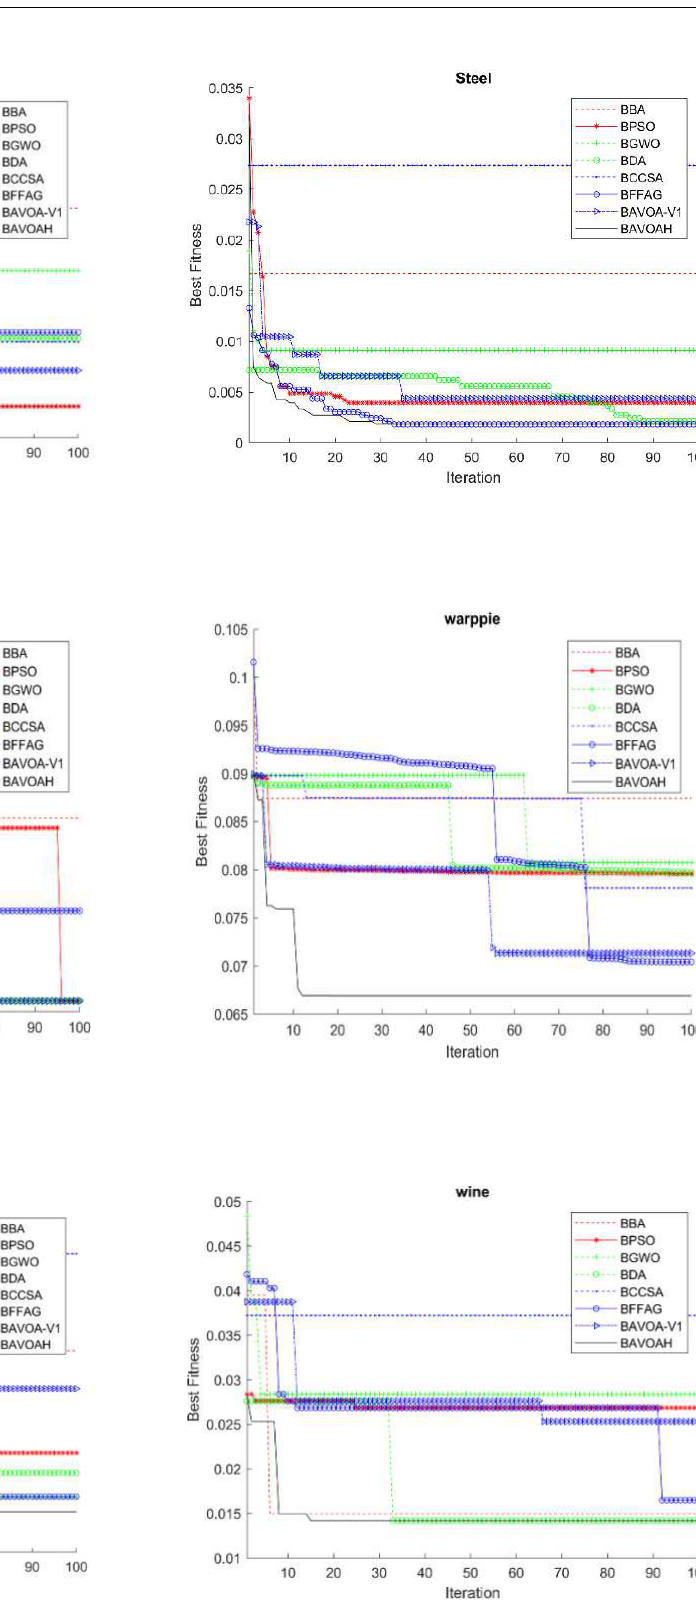
Figure 19. Comparison of the degree of convergence of the proposed BAOVAH (hyper-heuristic) and BAVOA-V1 (multi-strategy) method on the fifth six data sets.